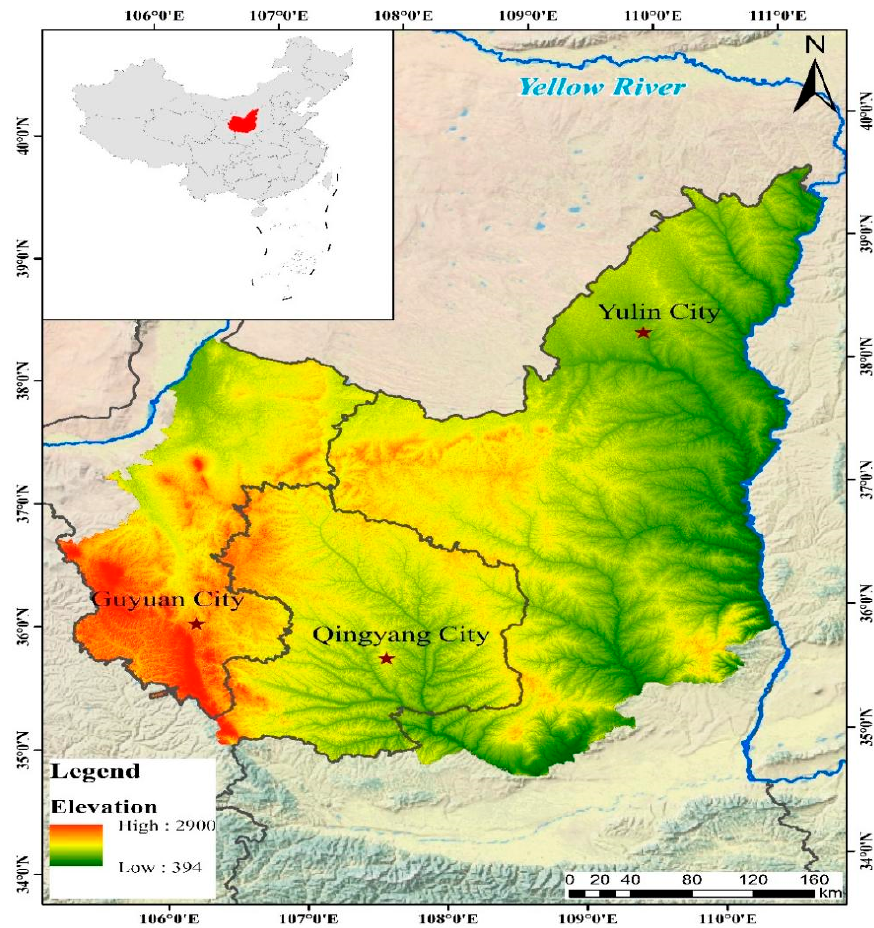
Figure 2. Map of the study area (Source: Arc GIS 10).